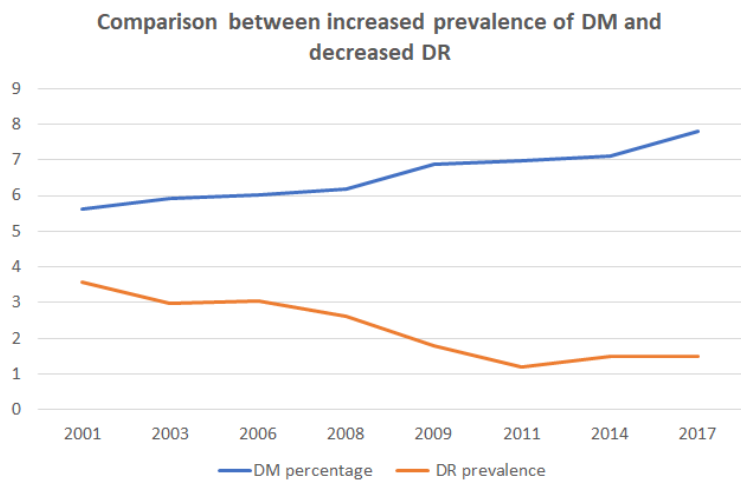
Figure 3. Relationship between the increase in the prevalence of diabetes mellitus versus the decrease in the prevalence of diabetic retinopathy.